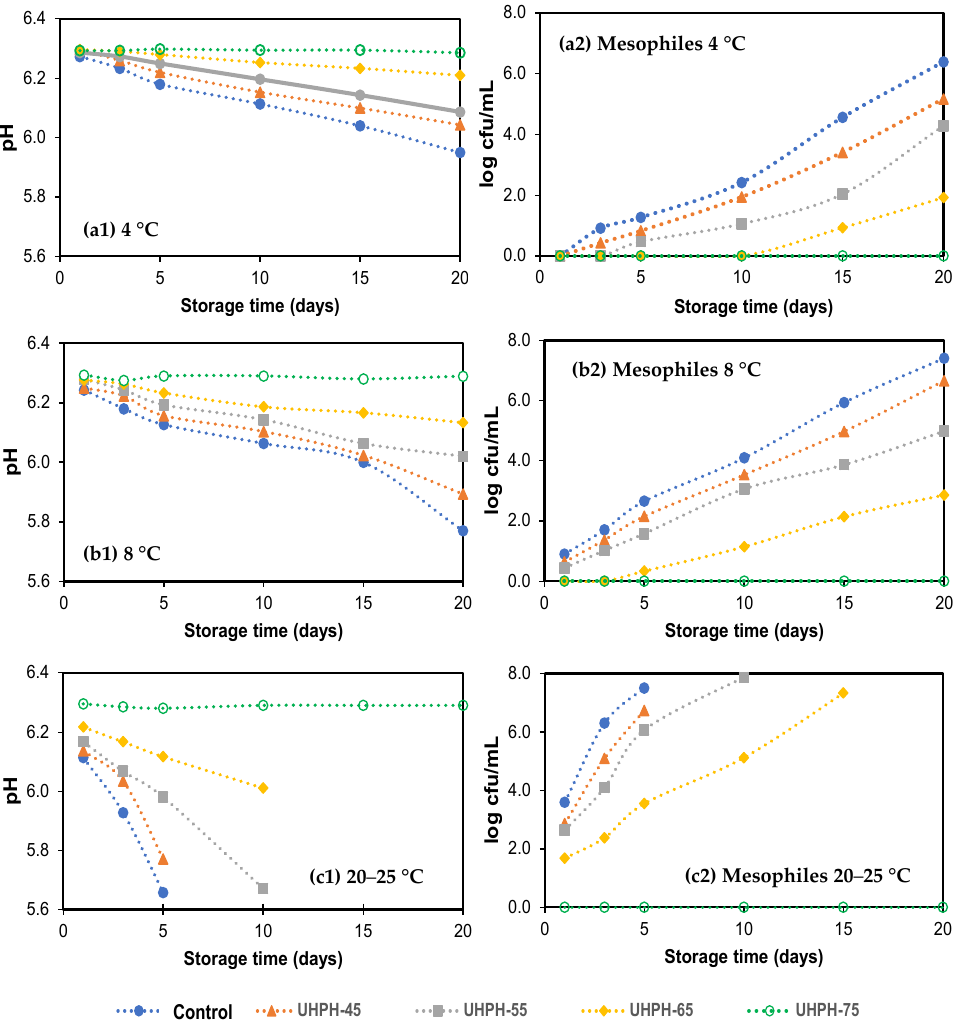
Figure 1. pH and mesophilic bacteria counts (cfu/mL) in untreated (control) and ultra-high-pressure- homogenized fish broths at 300 MPa at different inlet temperatures (45, 55, 65, and 75 ◦ C) during storage at ( a1 , a2 ) 4 ◦ C, ( b1 , b2 ) 8 ◦ C, and ( c1 , c2 ) room temperature (20–25 ◦